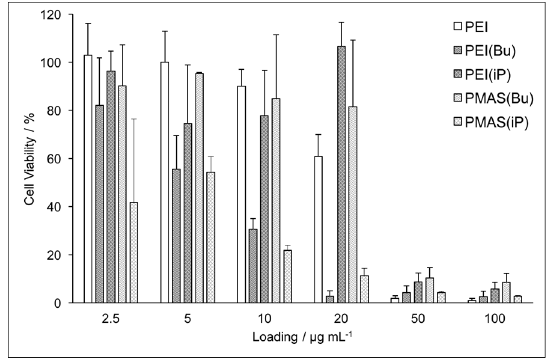
Figure 2. Biocompatibility of TAC-based polymers at various doses in HEK-293T cells following 48 h incubation. Viability is measured by trypan blue dye exclusion and normalized to untreated cells. Error bars show the standard deviation of triplicate measurement.